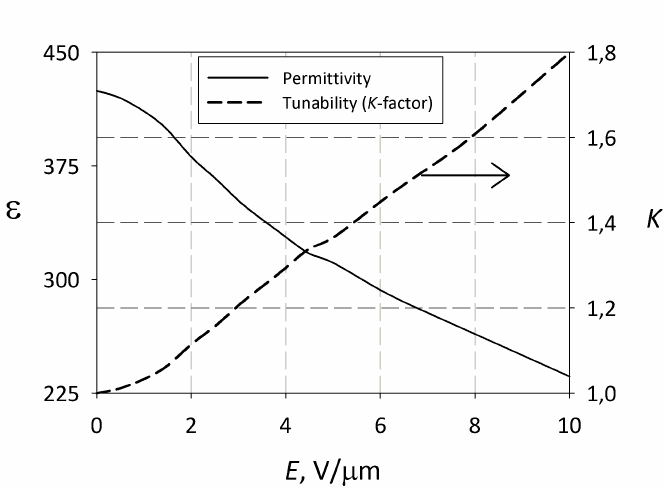
Figure 4. Measured ferroelectric ceramic sample permittivity and tunability dependencies on the electric